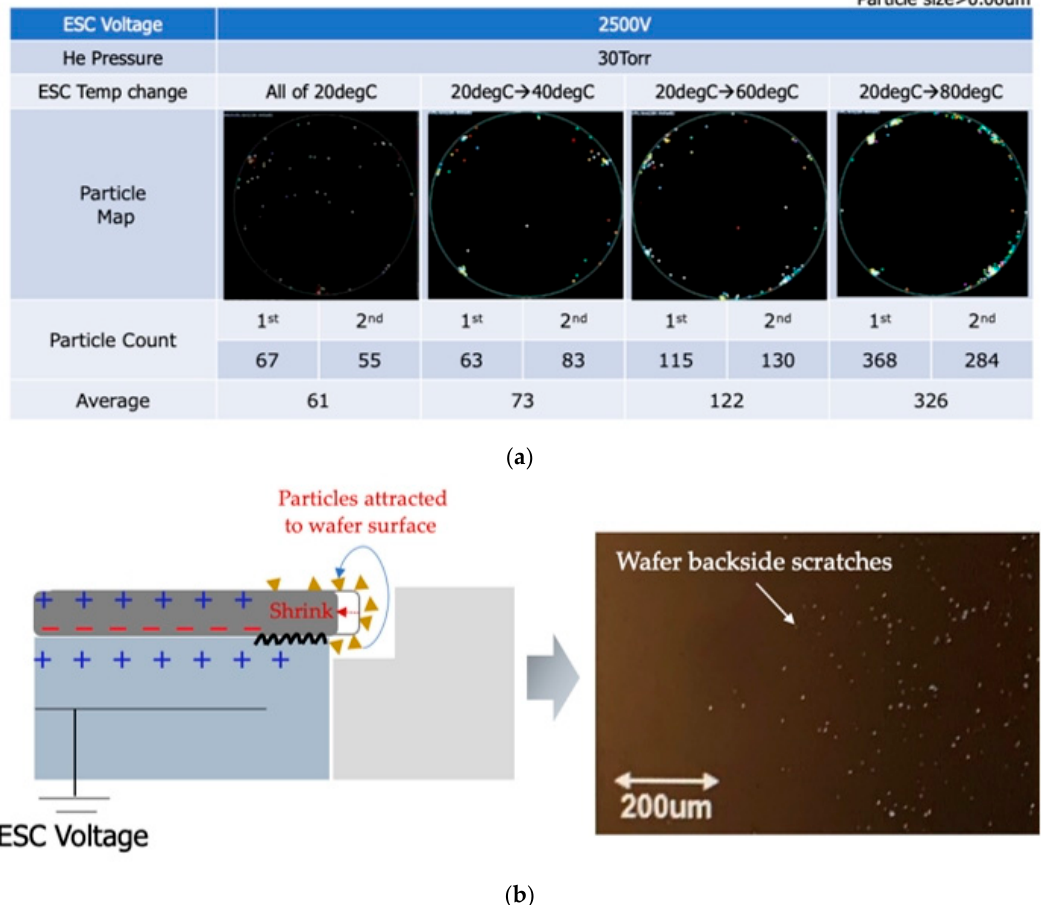
Figure 15. Particle deposition under various temperature changes for the ESC. ( a ) Particle distribution results under different temperature changes for the ESC. ( b ) Thermal expansion of the wafer because of the heating of the ESC, which resulted in scratches on the backside of the wafer.